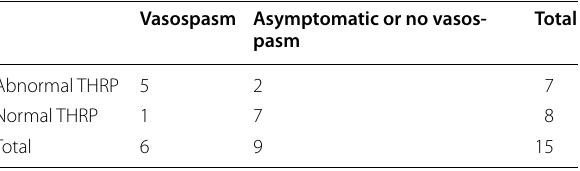
Table 2 Abnormal THRT is predictive of subsequent vasos- pasm